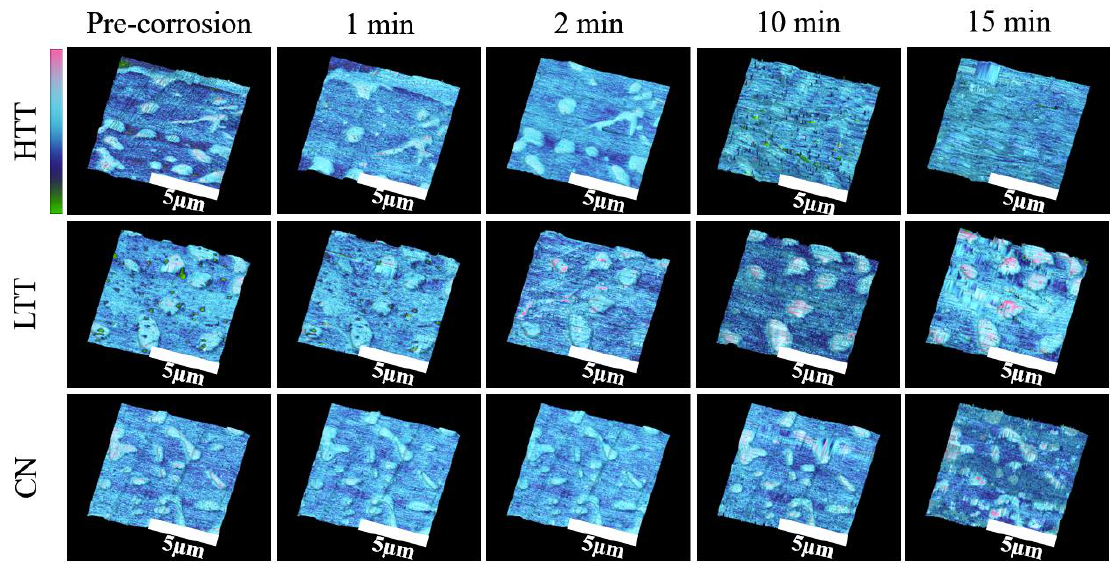
Figure 6. SKPFM Volta potential maps (green to pink color scale, 400 mV full scale) overlaid on the evolving 3D topography (30 nm full scale) of the three heat-treated MSSs as a function of immersion time in 1 M NaCl solution.